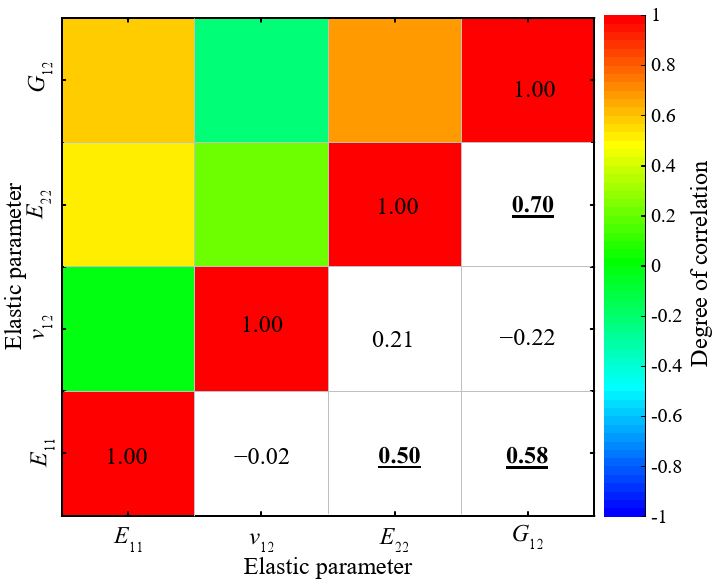
Figure 8. Scatter plot of the four elastic parameters of the T800/X850 composite. ( a ) E 11 vs. v 12 ; ( b ) E 11 vs. E 22 ; ( c ) E 11 vs. G 12 ; ( d ) v 12 vs. E 22 ; ( e ) v 12 vs. G 12 ; ( f ) E 22 vs. G 12 .